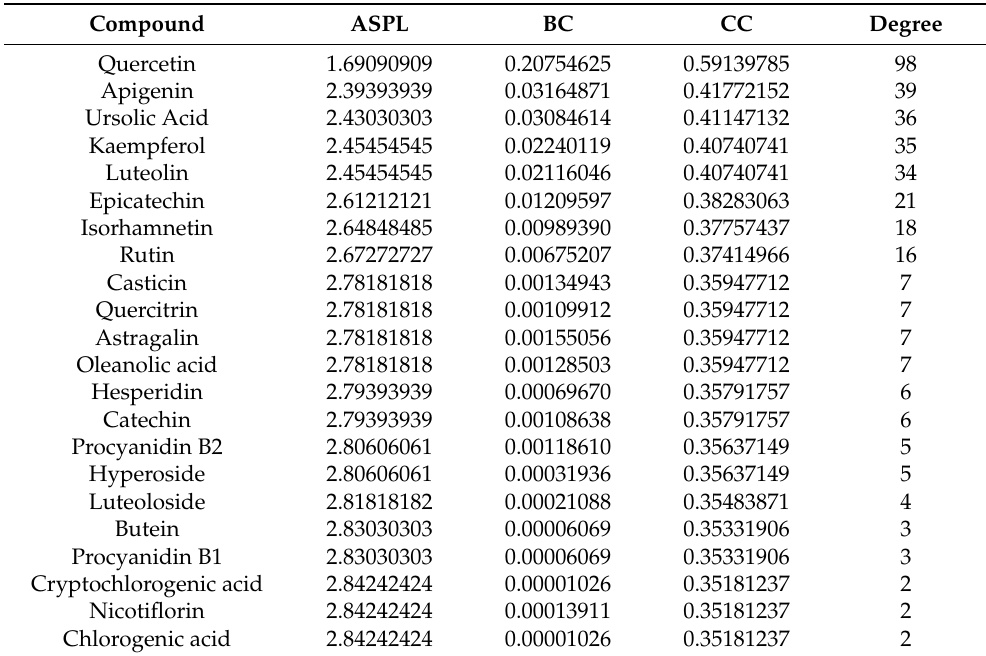
Table 2. The active compounds and their parameter information. ASPL, BC, CC and degree in the table correspond to average shortest path length, betweenness centrality and closeness centrality and